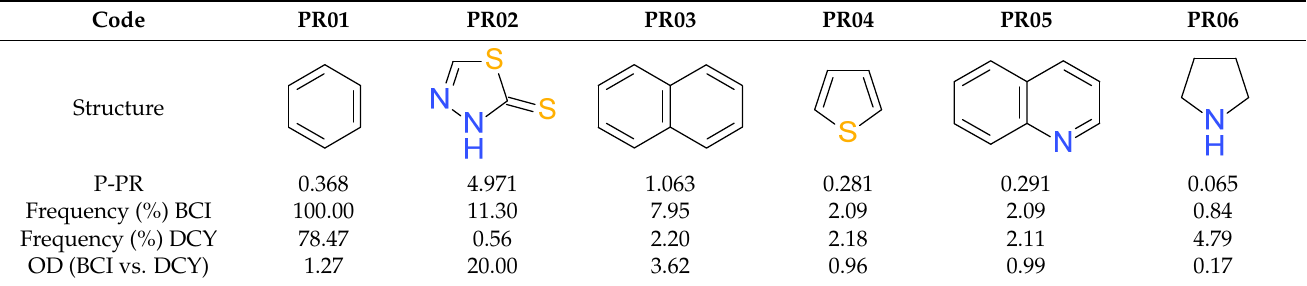
Table 2. The structures of the most frequent PR fragments generated in the BCI set and their P-PR scores and odds values.